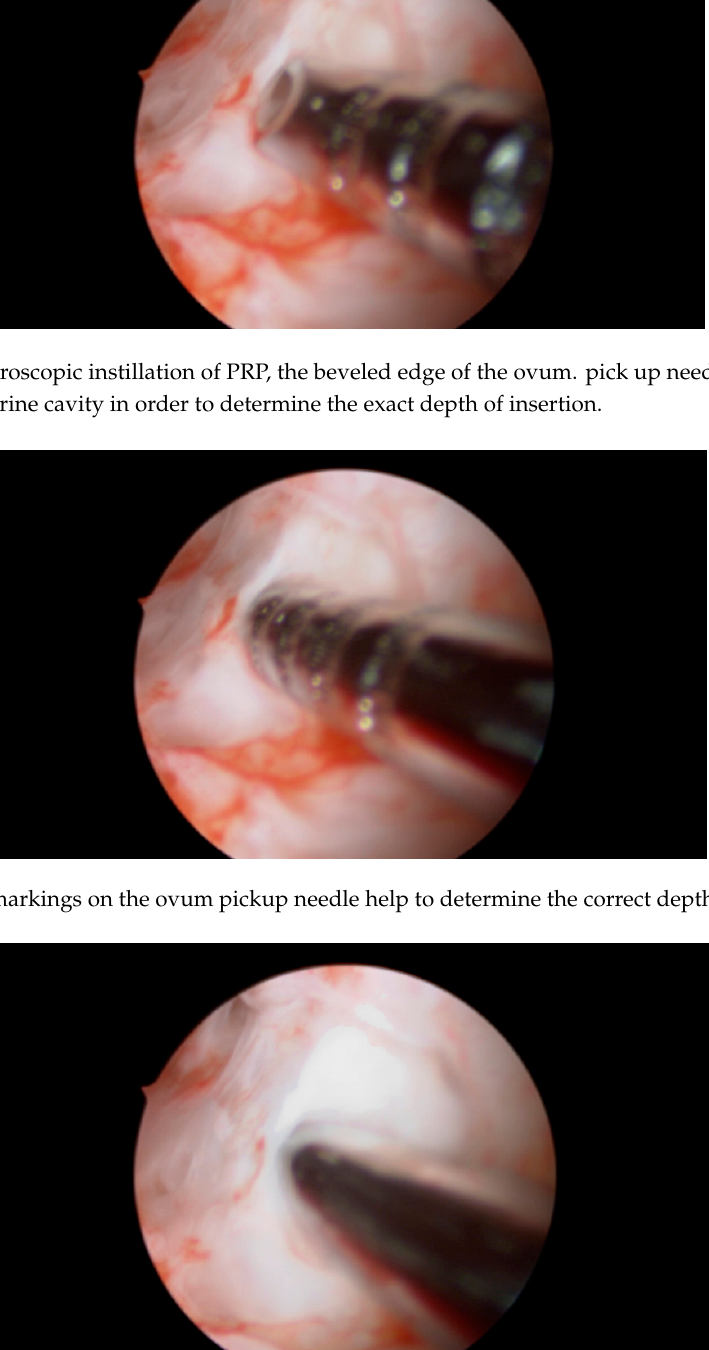
Figure 4. Prepared PRP is pushed into the endomyometrial junction and the needle is withdrawn under vision. No leakage of injected fluid was seen on withdrawal of the needle; PRP was instilled within 20 to 30 minutes of its preparation.